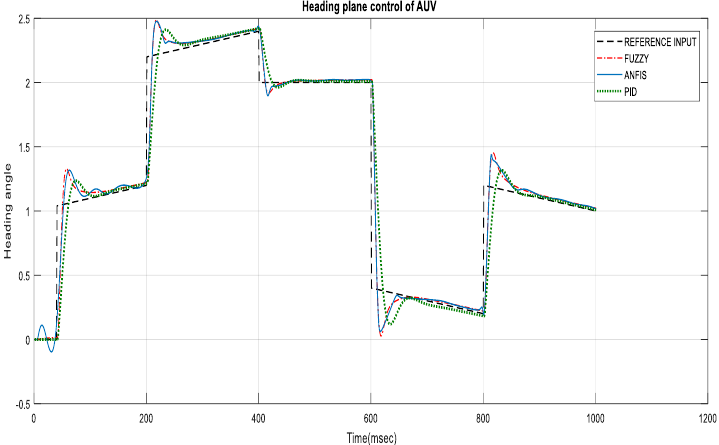
Figure 23. Ramp response of heading plane control.